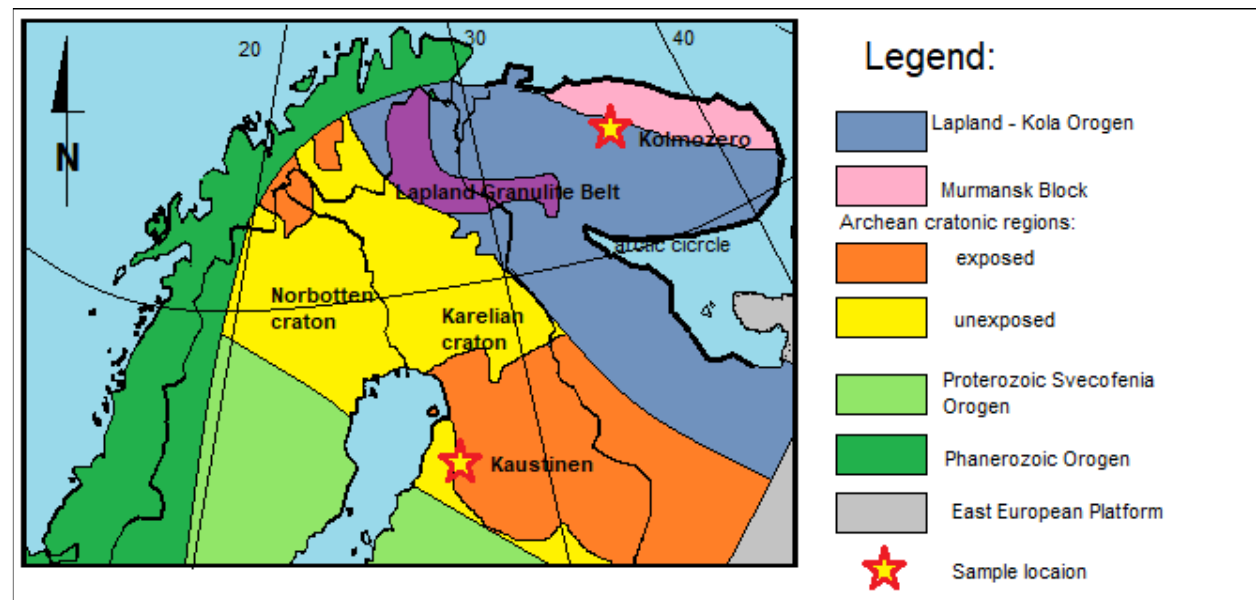
Figure 1. Simplified geological—tectonic map of the N Skandinavia (after [17]) with the samples’ location.